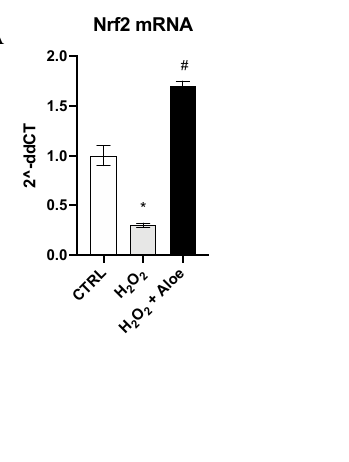
Figure 2. Effects of pre-treatment with aloe extract on Nrf2 ( A ), SOD2 ( B ), Catalase ( C ) mRNA expression. Effects of pre- treatment with aloe extract on Nrf2 levels ( D ), SOD activity ( E ), Catalase activity ( F ). Values are expressed as the means ± SD. * p < 0.0001 vs. CTRL; # p < 0.0001 vs. H 2 O 2 . 3.4. Effects of Aloe Extracts on Inflammatory Markers As estimated, H 2 O 2 induced a significant upregulation of mRNA expression of pro- inflammatory enzyme COX-2, a common feature of inflammation caused by oxidative stress, and a marked expression of proinflammatory cytokines IL-1 β , IL-6 and TNF- α compared to control group ( p < 0.0001 vs. control group; Figure 3). Pre-treatment with aloe extract in H 2 O 2 stimulated HCE cells suppressed the increased mRNA for the inflamma- tory enzyme COX-2 and caused a marked reduction in the expression of the message of the inflammatory cytokine TNF- α , IL-6 and IL-1 β ( p < 0.0001 vs. H 2 O 2 group; Figure 3). To confirm the anti-inflammatory effect of the aloe extract we measured the mature protein levels in the supernatants of HCE cells stimulated with H 2 O 2 . TNF- α , IL-6 and IL-1 β levels were markedly increased ( p < 0.0001 vs. control group; Figure 3). By contrast aloe extract pre-treatment blunted the increase of TNF- α , IL-6 and IL-1 β in the HCE cells stimulated with H 2 O 2 ( p < 0.0001 vs. H 2 O 2 group; Figure 3). PGE 2 levels metabolite of COX-2 was also markedly released in the supernatants of HCE cells upon H 2 O 2 stimulation ( p < 0.0001 vs. control group; Figure 3). Pre-treatment with aloe extract resulted in a powerful reduction of PGE 2 levels ( p < 0.0001 vs. H 2 O 2 group; Figure 3).